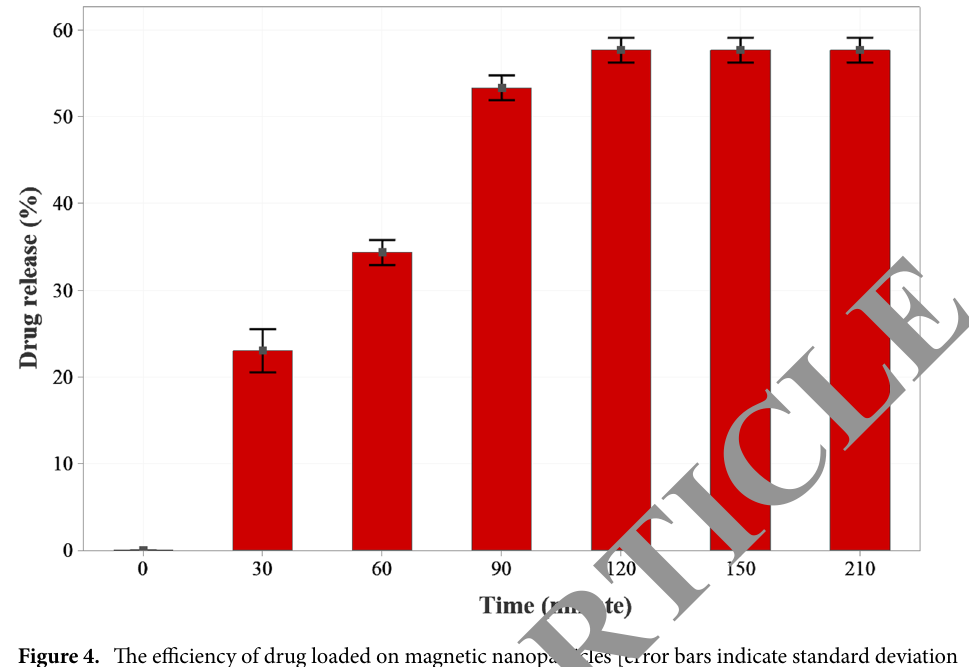
Figure 4. The efficiency of drug loaded on magnetic nanoparticles [error bars indicate standard deviation p < 0.05)].